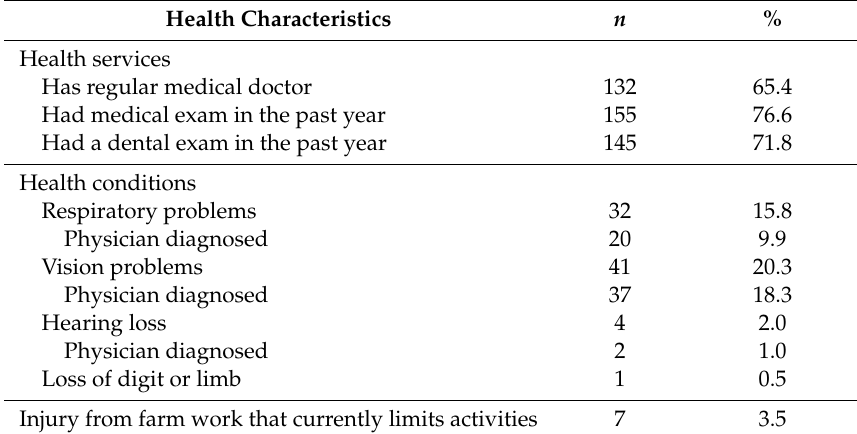
Table 2. General health characteristics, Latinx child farmworkers in North Carolina, 2017 (N =